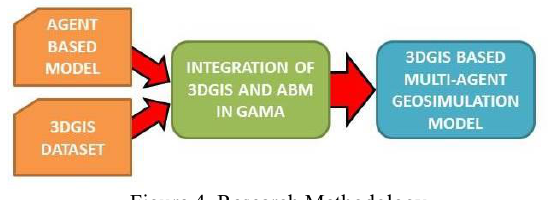
Figure 4. Research